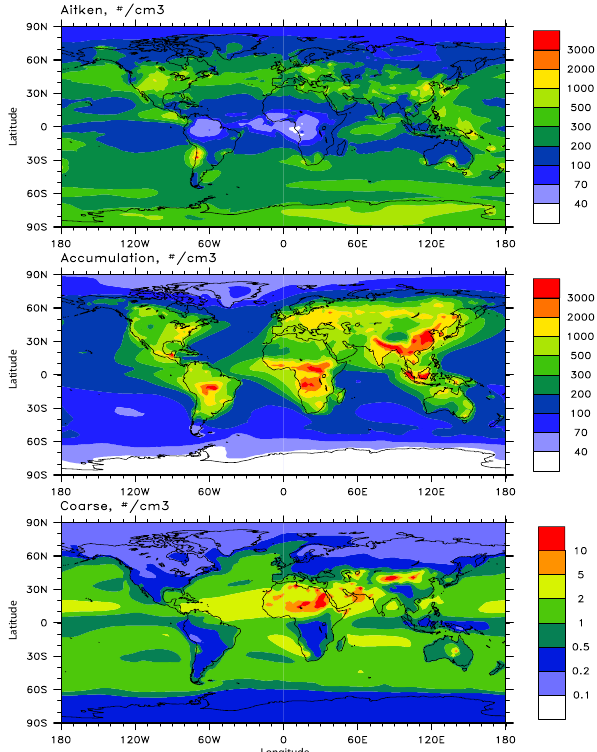
Fig. 3. Annual averaged global distributions of aerosol number con- centrations (numbercm − 3 ) in the lowest model layer for the Aktien mode, accumulation mode, and coarse mode aerosols predicted by the